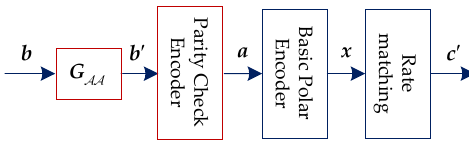
Figure 3. Systematic parity check and CRC-aided (PCCA)-polar encoder.